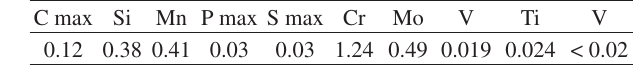
Table 1. Chemical composition of the pipeline material (weight